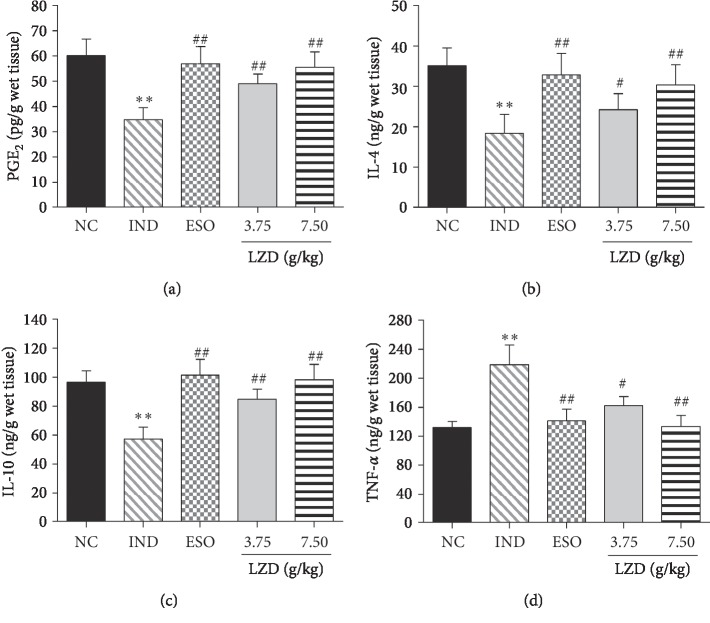
Effect of LZD on duodenal mucosal PGE2 (a), IL-4 (b), IL-10 (c), and TNF-α (d) contents measured in IND-induced duodenal ulceration model. IND-induced ulcer rats were treated with either ESO (4.17 mg/kg) or LZD (3.75 and 7.50 g/kg). Results are expressed as mean ± SEM, n = 6. Asterisks and pound signs indicate significant differences: ∗∗P < 0.01 versus normal control (NC); #P < 0.05 and ##P < 0.01 versus negative control (IND).